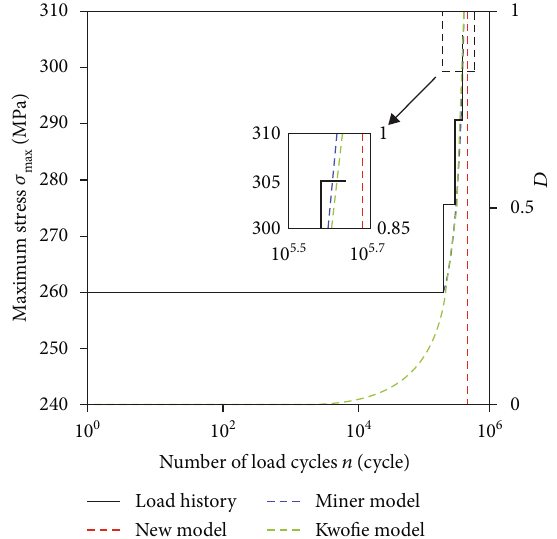
Figure 12: Comparison of experimentally obtained and corresponding theoretical remaining life values predicted by the Miner, Kwo fi e, and proposed new model for 6082-T6 aluminium alloy under four-level cyclic loading in the range 280 – 305 – 260 – 240 MPa.